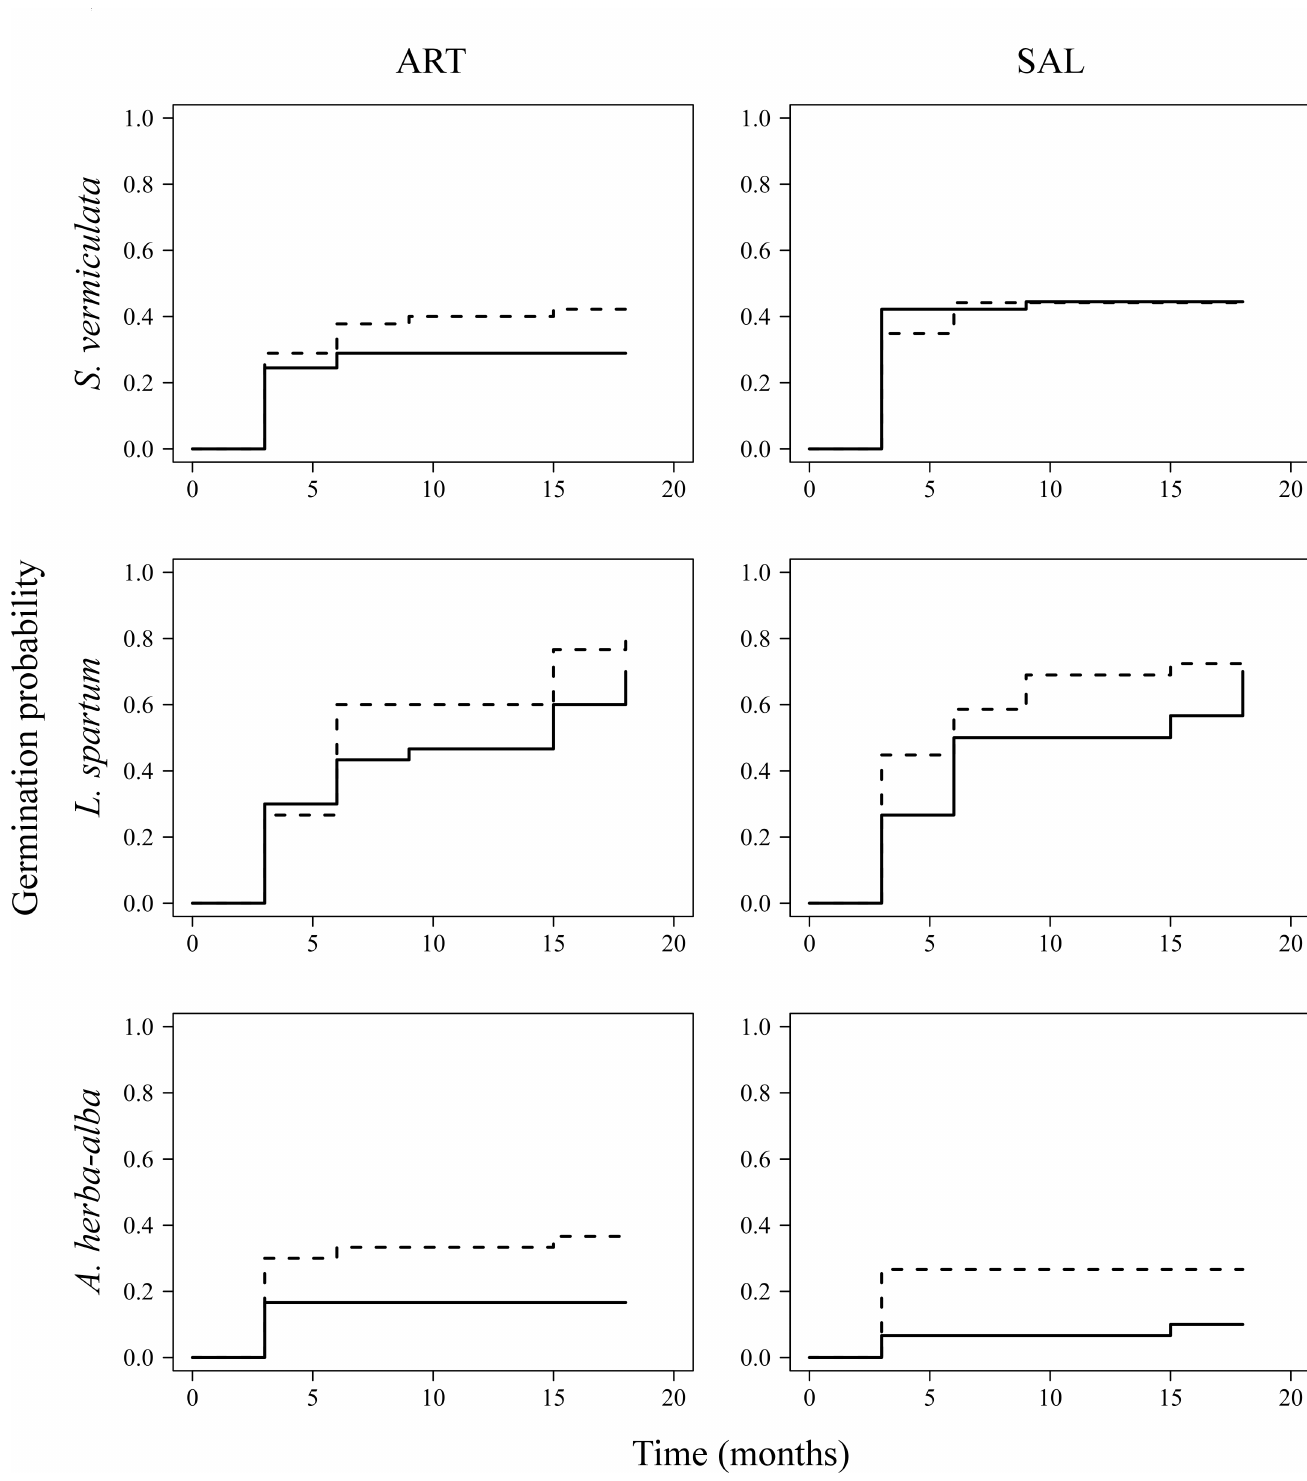
Fig 3. Seed germination (Kaplan-Meier curves) of target species by treatment and shrub microsite. Dashed and solid lines represent germination of seeds sowed with and without the addition of AC respectively. ART, A . herba-alba ; SAL, S . vermiculata .